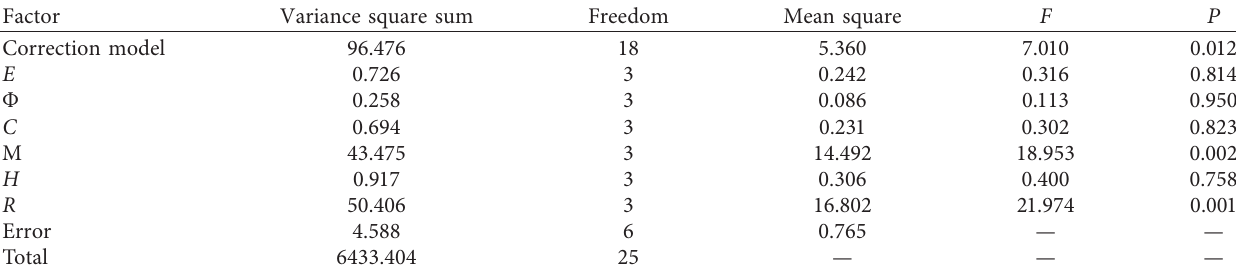
Table 3: Variance analysis for the stress concentration zone.